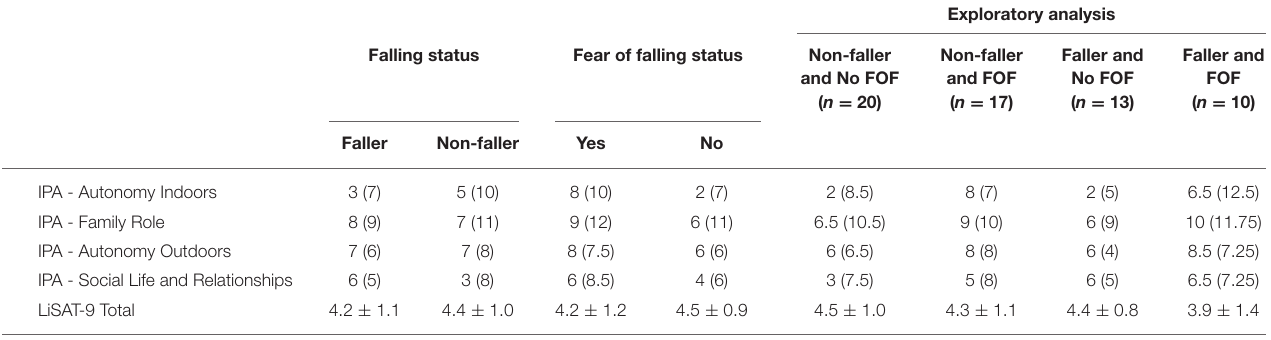
TABLE 2 | IPA and LiSAT-9 scores.